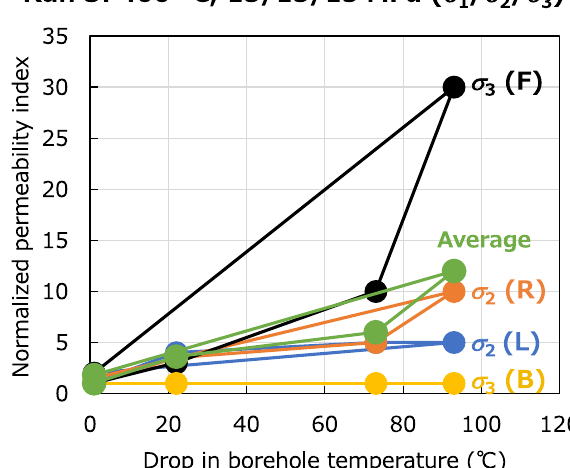
Fig. 9 Relationship between the normalized permeability index and drop in borehole temperature for each direction in Run 3. σ x (y) denotes the outlet face, y (R: right face, L: left face, F: front face, B: back face) subjected to the principal stress, σ x (x: 1, 2,